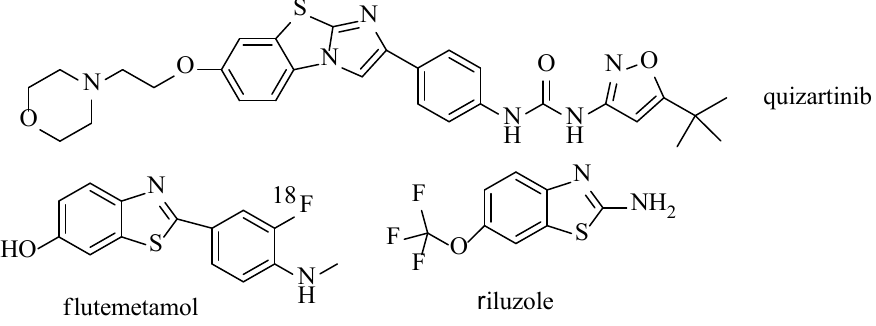
Figure 1. FDA-approved drugs.